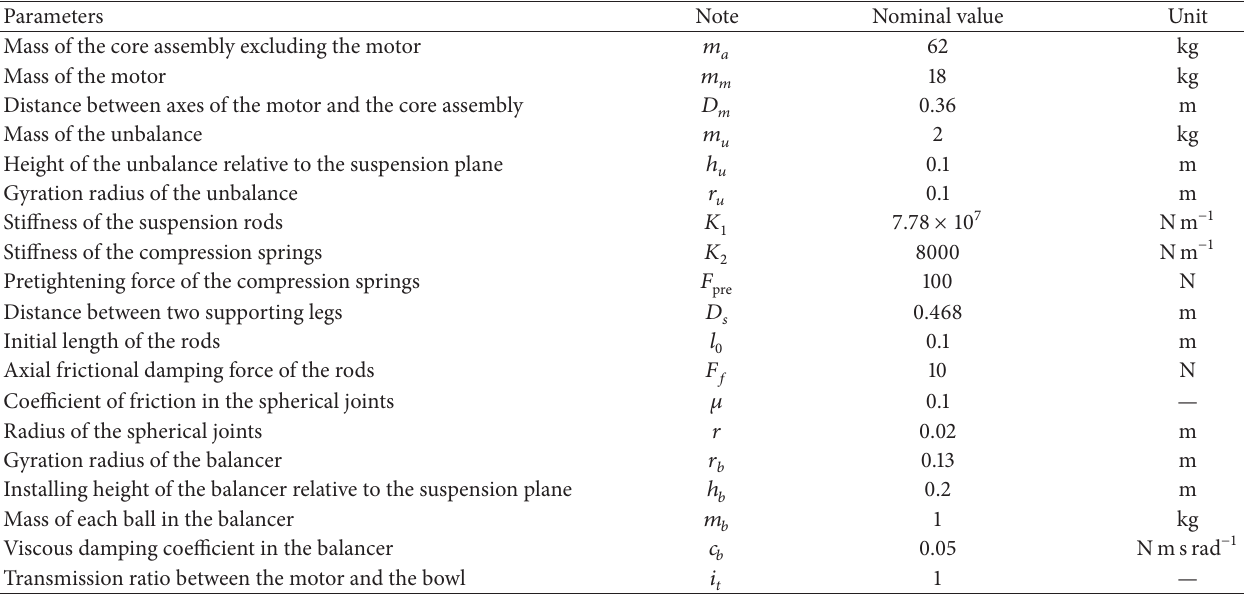
Table 1: Parameter